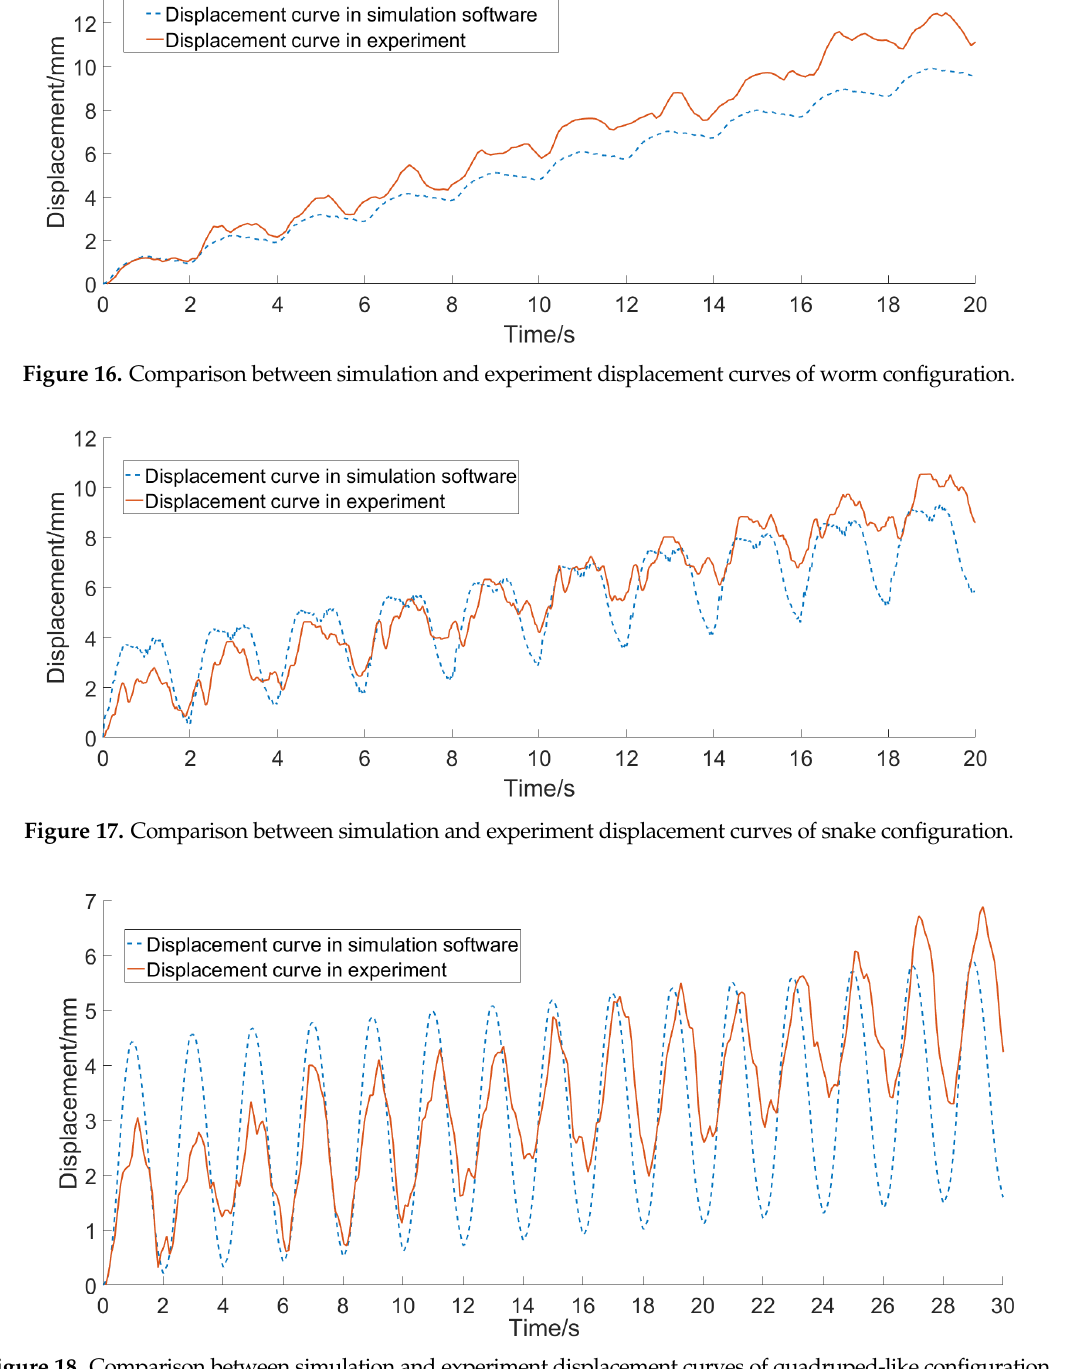
Figure 18. Comparison between simulation and experiment displacement curves of quadruped-like